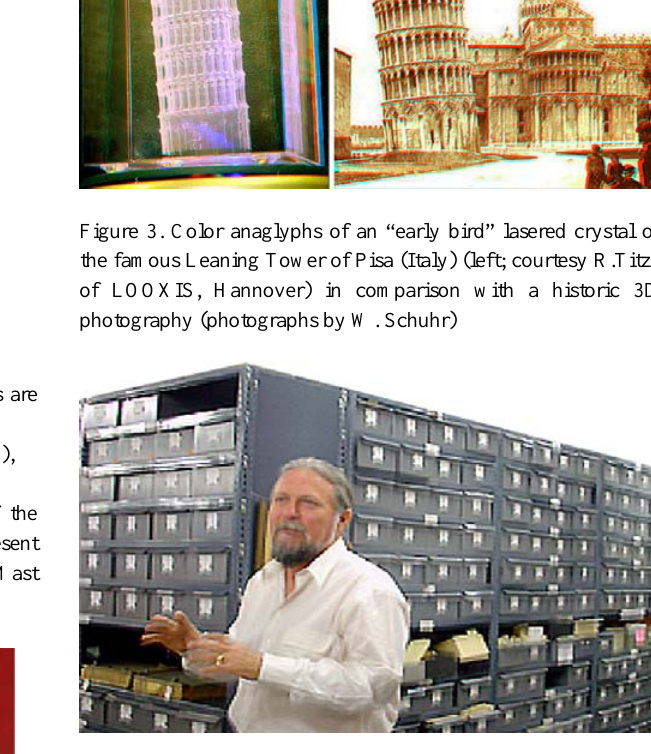
Figure 4. Inside the Keystone-Mast Collection, carrying approximately 350.000 original glass slides of international historic 3D photography: Steve Thomas, head of the CMP in Los Angeles (USA) in front of his “treasure in 3D” (processed photography: courtesy